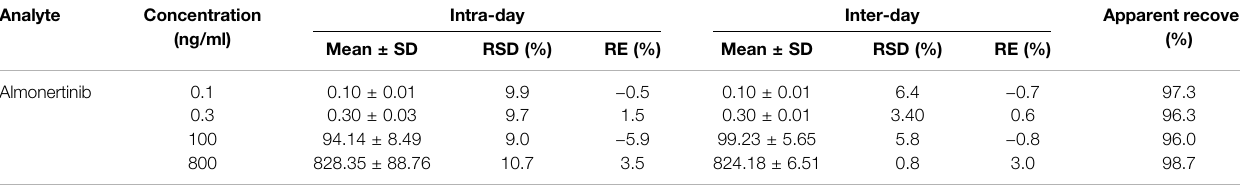
TABLE 3 | Precision and accuracy for almonertinib of QC samples in rat plasma ( n = 6). Analyte Concentration (ng/ml) Almonertinib